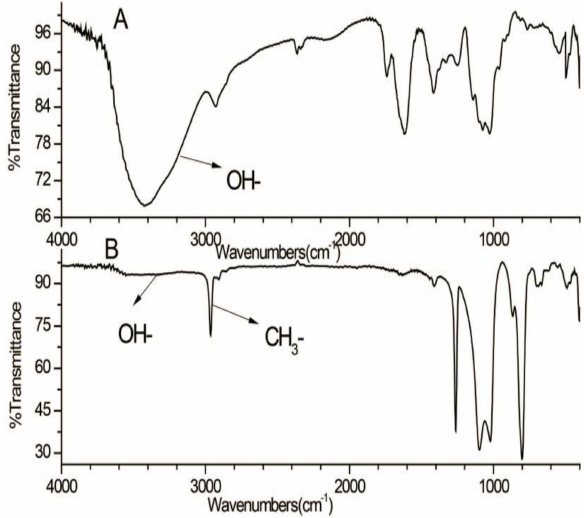
Figure 3. IR spectrum of PAP-3 ( A ) and its methylated product ( B